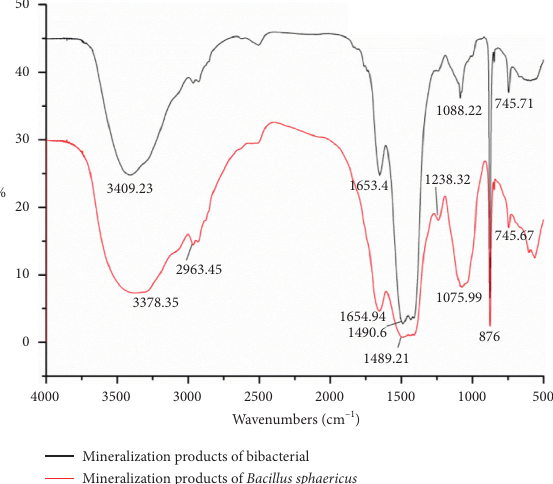
4000010% Mineralization products of bibacterial Mineralization products of Bacillus sphaericus Figure 9: FTIR spectra of the two